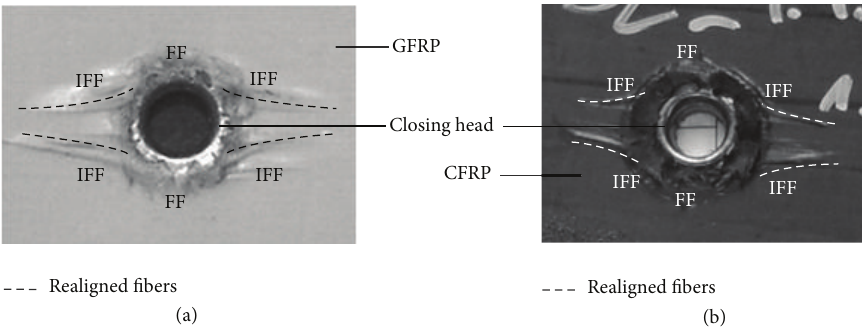
Figure 5: FF and IFF, caused by too small plasticization area (a) at hybrid joints with glass (GFRP) and (b) carbon fiber reinforced plastics (CFRP).